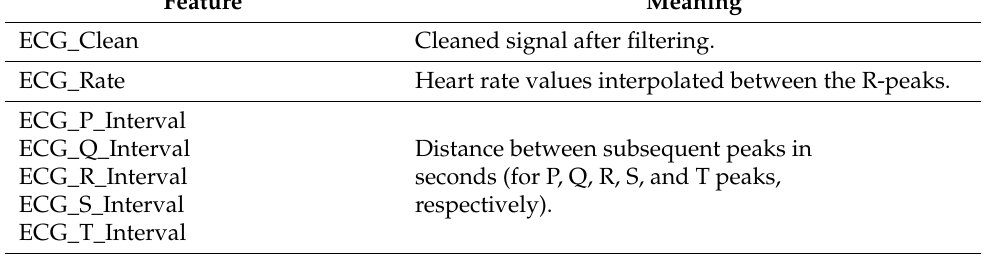
Table 2. Features extracted from the signals. Notes. EMG_front, medial frontalis muscle; EMG_zygo, zygomaticus major muscle; EMG_corr, corrugator supercilii muscle. Feature Meaning Cleaned signal after